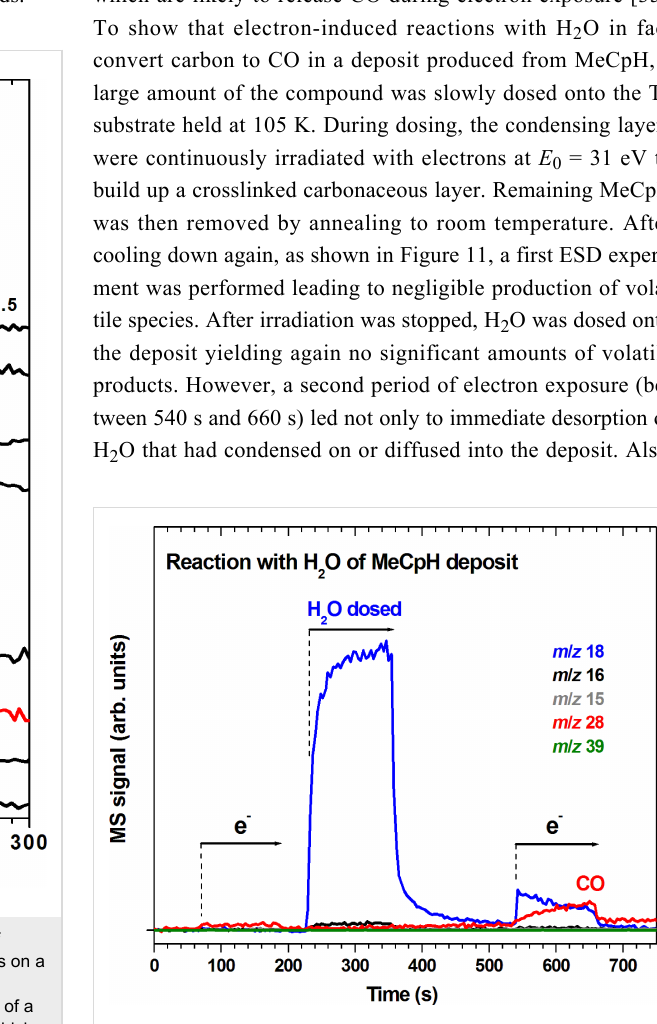
Figure 11: MS signals recorded during electron exposures (e − ) and leaking of H 2 O (H 2 O) onto a deposit that has been prepared by dosing a large amount of MeCpH onto a Ta substrate held at 105 K and simul- taneous electron exposure at E 0 = 31 eV to build up a crosslinked car- bonaceous layer. Remaining MeCpH was removed by annealing to room temperature prior to cooling the substrate down again and starting the experimental sequence shown here. During leaking of H 2 O, an amount of vapour corresponding to 2–3 monolayers was applied. During the two electron irradiation periods, electron expo- sures of 2 mC/cm 2 each were applied at I p = 17 µA/cm 2 at E 0 = 31 eV. The m / z ratios 18, 16, 15, and 28 were recorded to monitor leaking of H 2 O as well as possible formation of CH 4 and CO. The m / z ratio 39 was included to show that desorption of MeCpH is